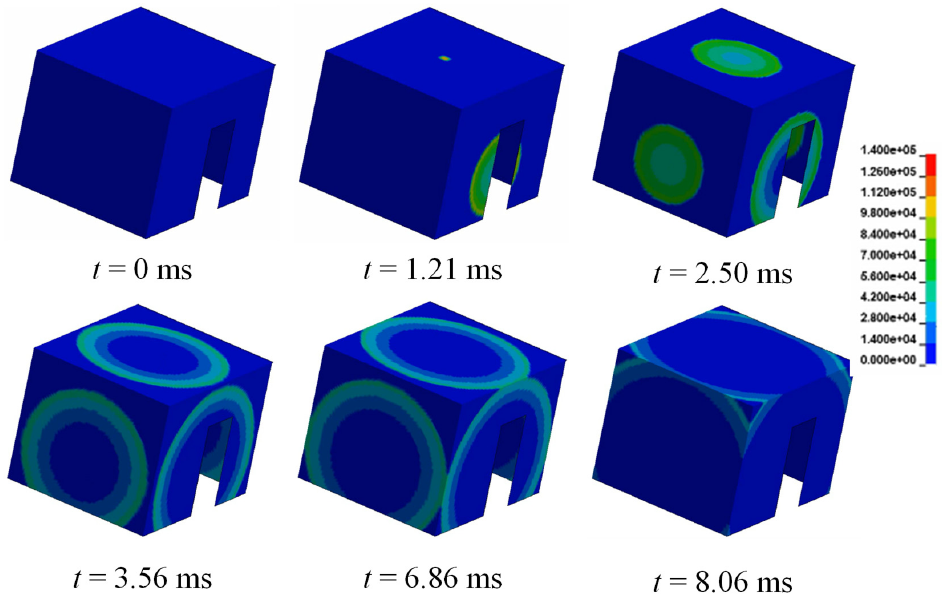
Figure 8. Pressure isovalues (view from the inner door) on the interior faces of the room where the detonations were carried out for the T0 test. The color scale is the pressure values in Pa.